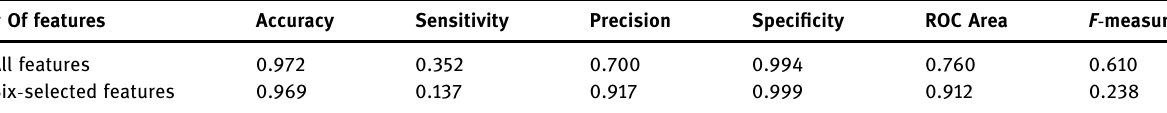
Table 4: Performance of all features vs six - selected features by using AdaBoost # Of features